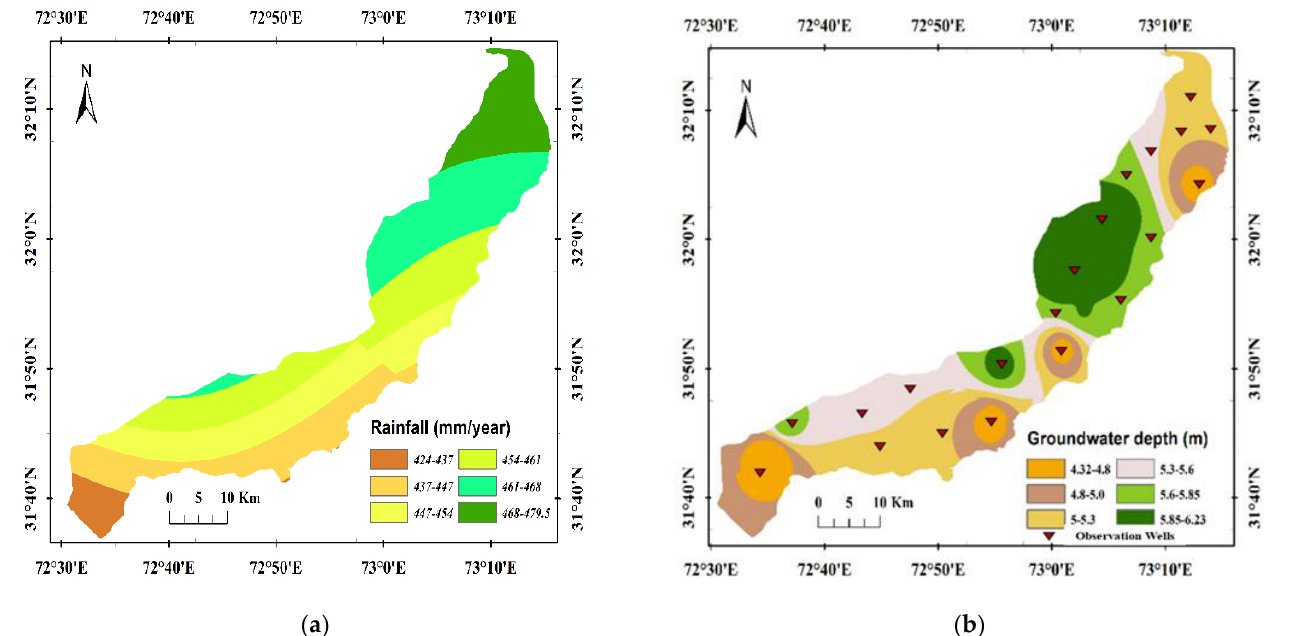
Figure 6. Spatial distribution of long-term annual ( a ) rainfall and ( b ) groundwater depth.